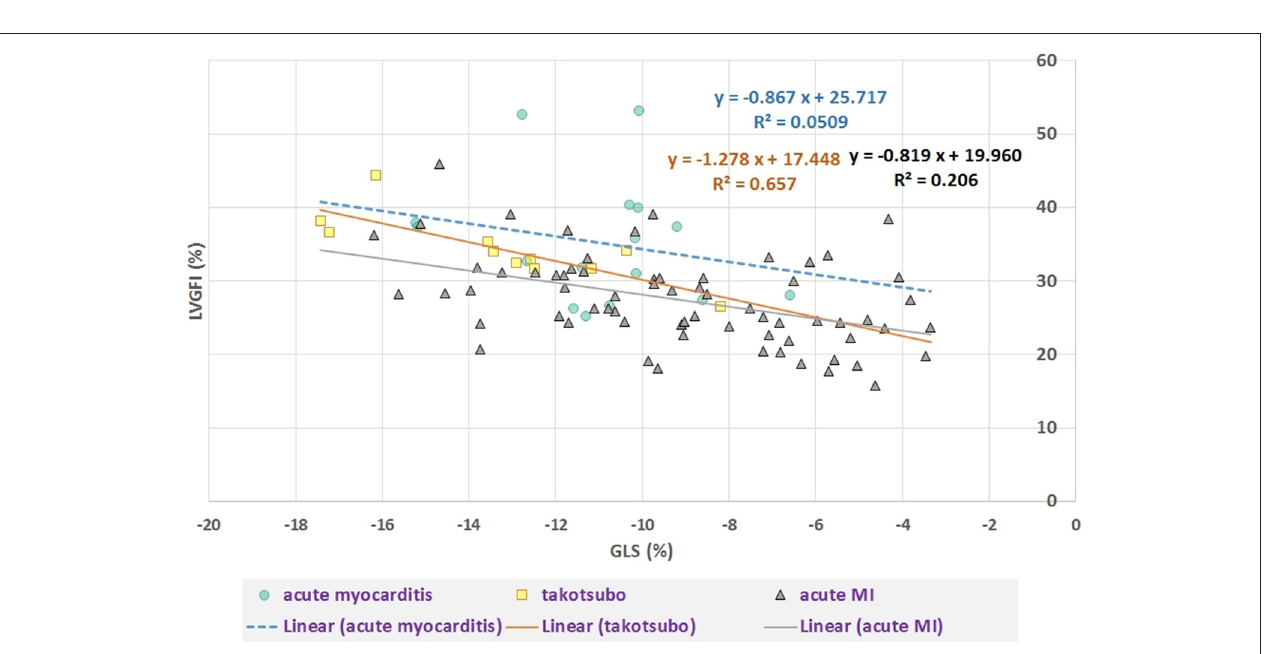
FIGURE 3 | Scatter plot of LVGFI (%) vs. GLS (%). Overall correlation R (R 0.81, P 0.005) results for the takotsubo group ( N = − =